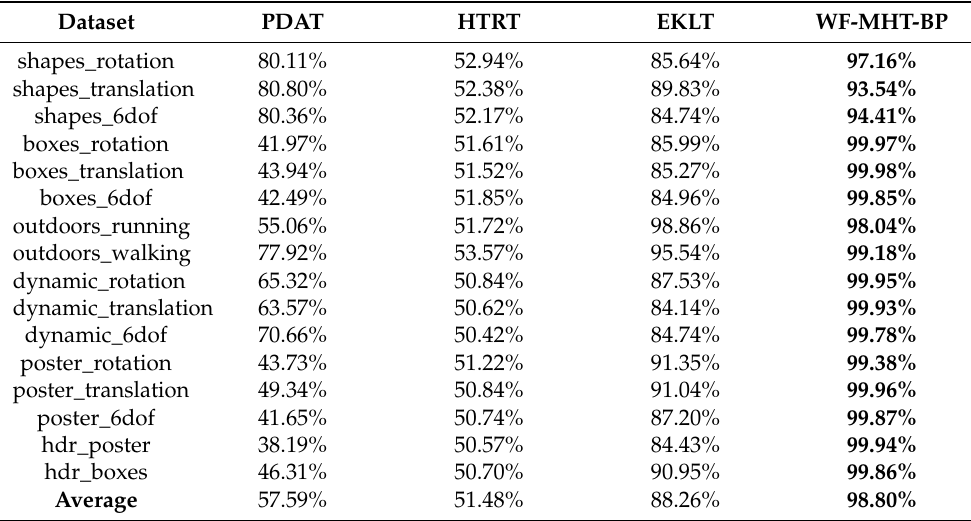
Table 2. Inlier ratios of PDAT/HTRT/EKLT/WF-MHT-BP